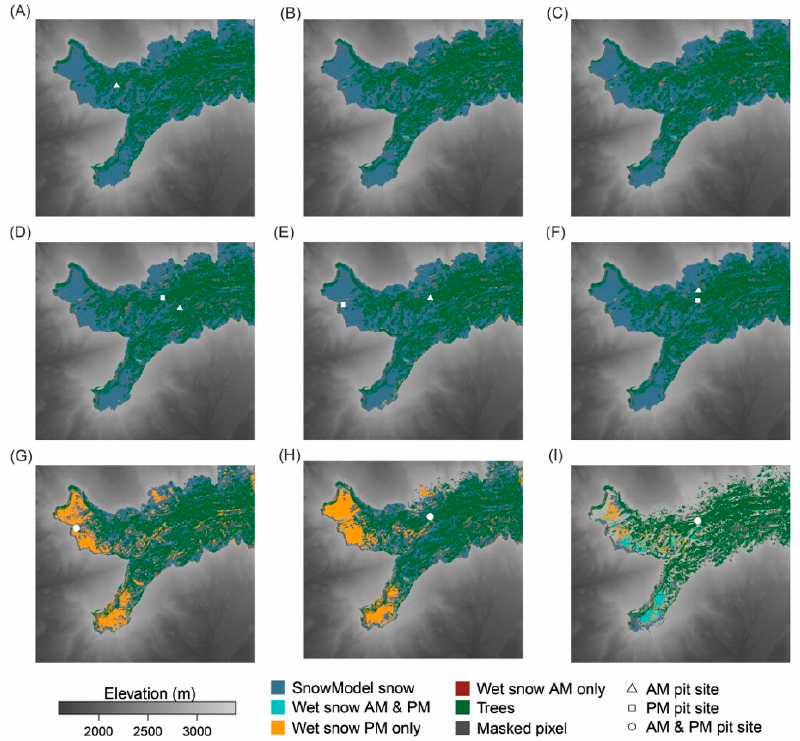
Figure 8. S1 diurnal wet snow comparison for ( A ) 28 January; ( B ) 9 February; ( C ) 21 February; ( D ) 4 March; ( E ) 16 March; ( F ) 28 March; ( G ) 9 April; ( H ) 21 April; and ( I ) 3 May 2020. S1 overpass dates with coincident field measurements show pit locations.